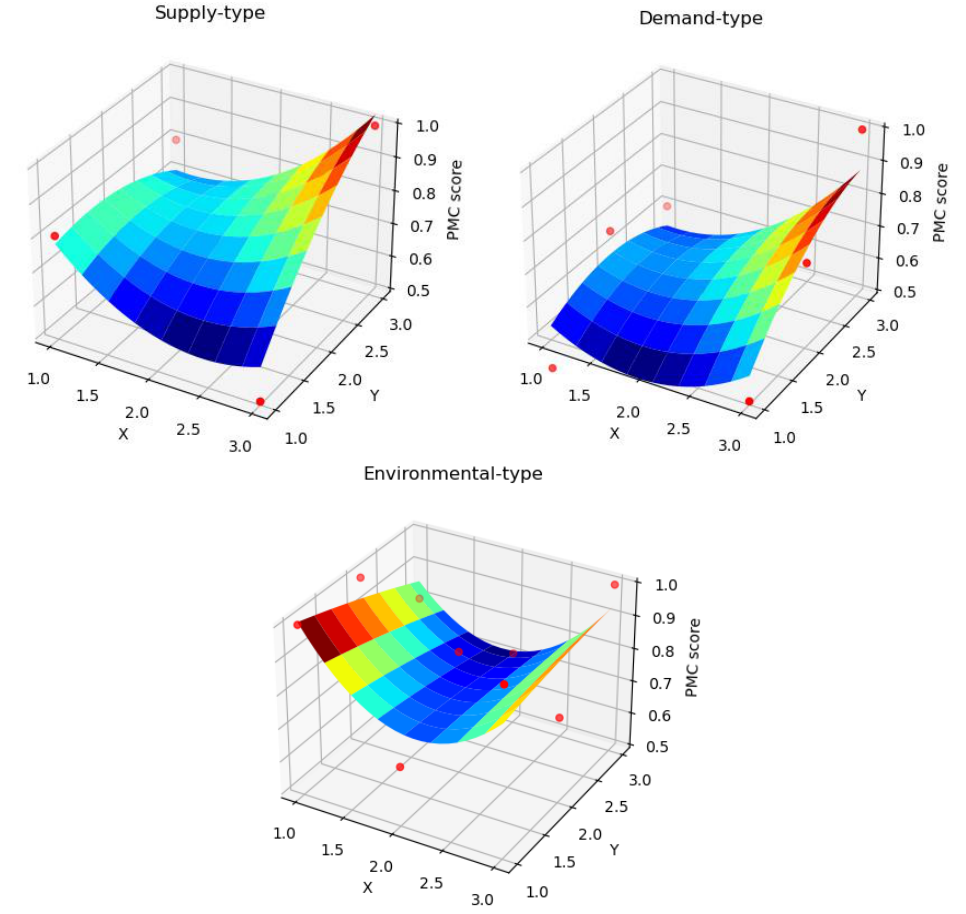
Figure 4. PMC surface map of three types of policy tools for the wind power industry.